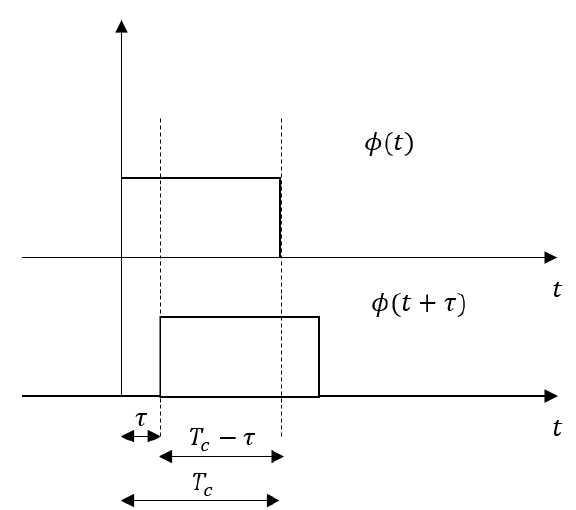
Figure A1. Representation of the two components of θ ( τ ) , i.e., φ ( t ) and φ ( t + τ ) , with respect to the time shift, τ